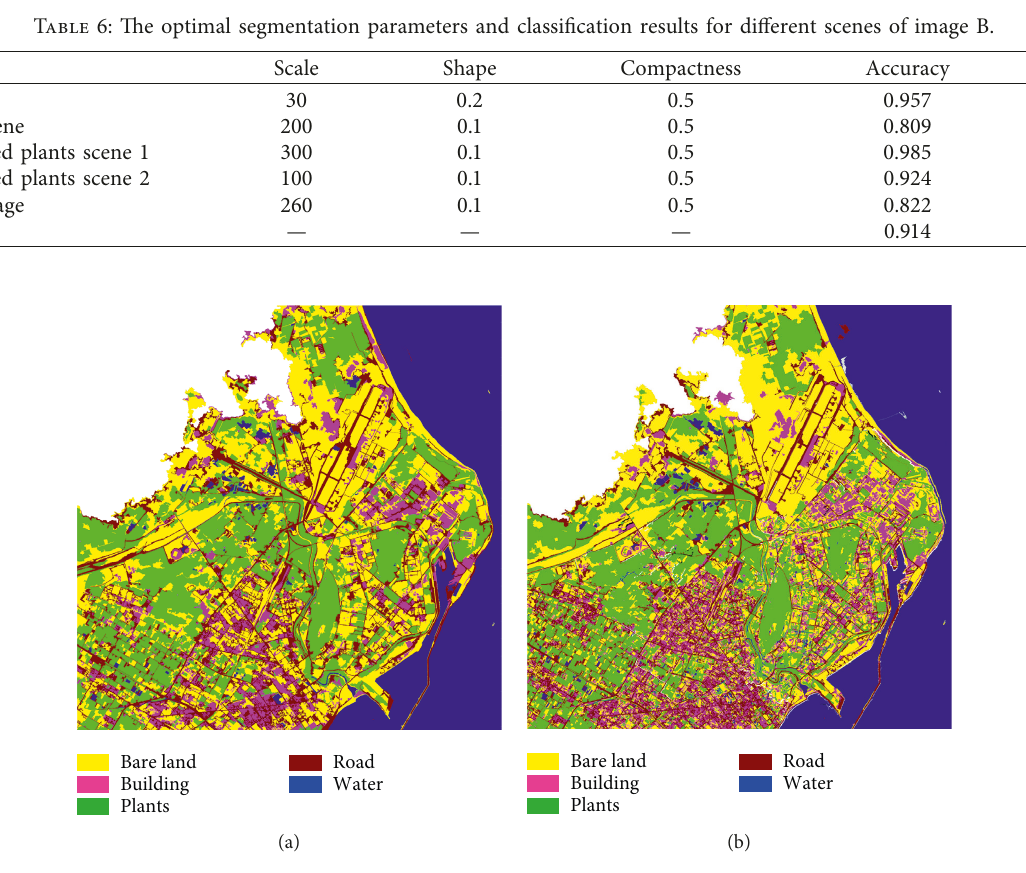
Figure 7: Classification of image A. (a) Overall classification. (b) Scene